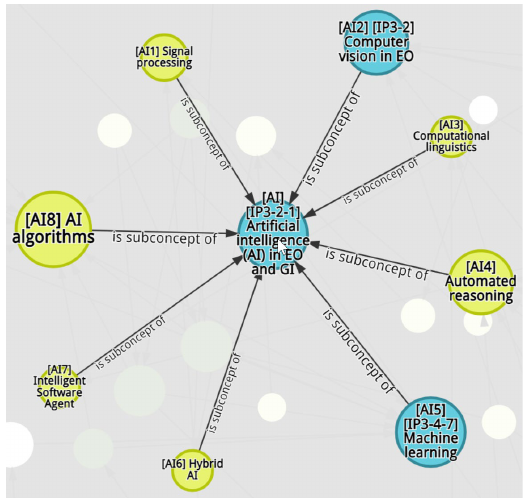
Figure 3 . Excerpt of the AI concept cluster in the EO4GEO BoK. Double Id codes (between square brackets) indicate connections with existing BoK concepts.